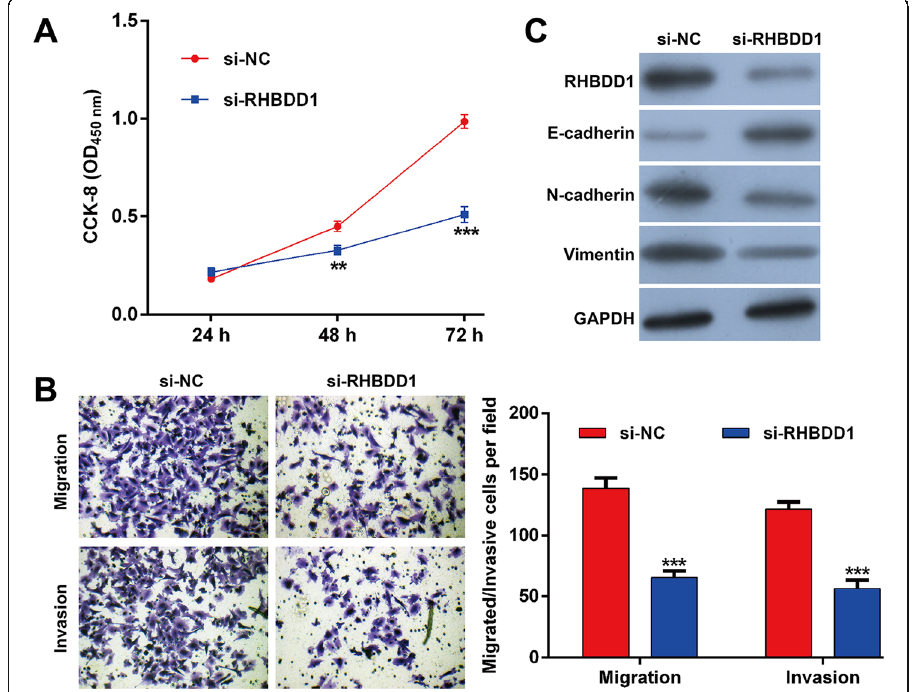
Fig. 4 Knockdown of RHBDD1 suppresses NSCLC cell proliferation, migration and invasion. A549 cells were transfected with si-RHBDD1 or si-NC for 48 h. a Cell proliferation was analyzed using the CCK-8 assay. b Transwell migration and invasion assays were performed in A549 cells. c The protein expressions of RHBDD1, E-cadherin, N-cadherin and vimentin were determined using western blotting. Data are expressed as means ± standard deviation (SD). ** p < 0.01, *** p < 0.001, compared with